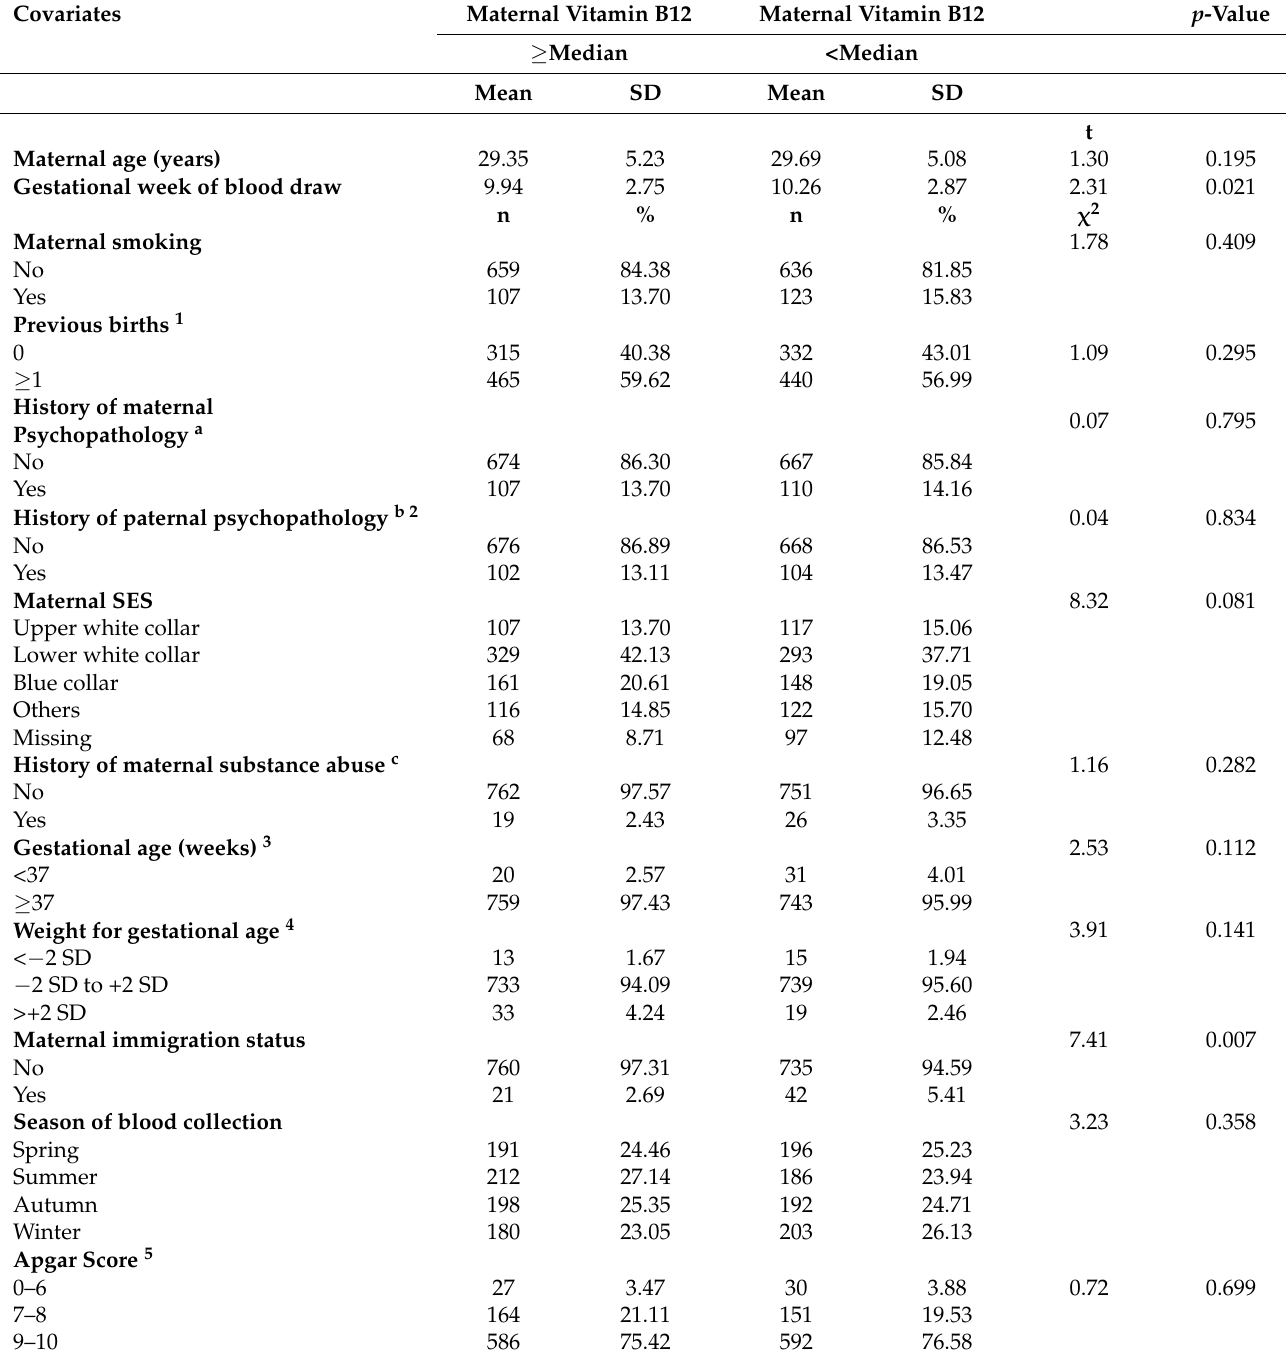
Table 1. Relationship between covariates and maternal vitamin B12 levels ( ≥ /< median) among